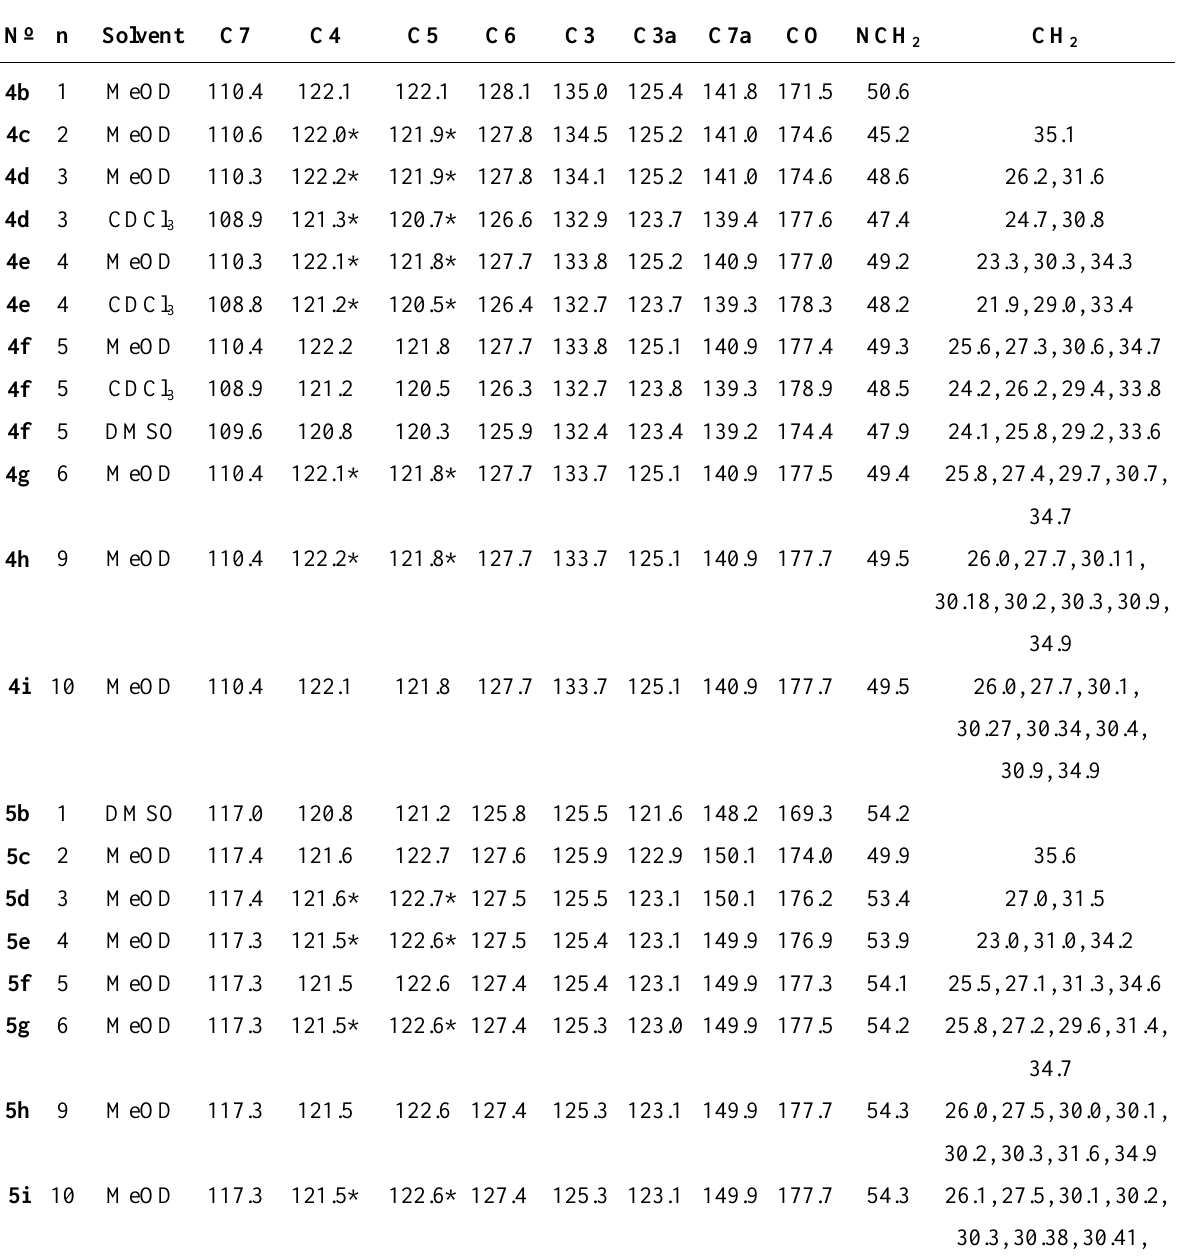
Table 5. 13 C-NMR chemical shifts ( δ in ppm) of 1 H -indazole carboxylic acids 4b-i and 2 H -indazole carboxylic acids